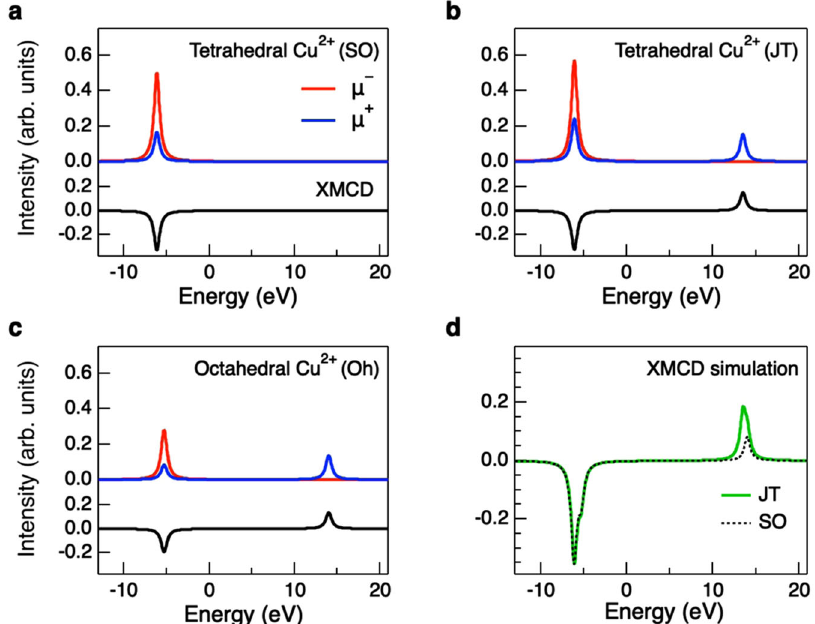
Fig. 4 Simulation of Cu L -edge XMCD. a – c The calculated XAS and XMCD spectra of Cu 2 + tetrahedron in the spin-orbit coupling (SO) scheme, Cu 2 + tetrahedron in the Jahn-Teller (JT) coupling scheme and Cu 2 + octahedron, respectively. The calculations are down with an external magnetic fi eld 1 T alone the z direction, and the polarization of incident X-ray lies on the xy plane. d The thick green line is the calculated XMCD spectra from 37.5% O h Cu 2 + and 62.5% T d Cu 2 + with Jahn-Teller distortion; the dashed black line is the result of 37.5% O h Cu 2 + and 62.5% spin-orbital entangled T d Cu 2 +